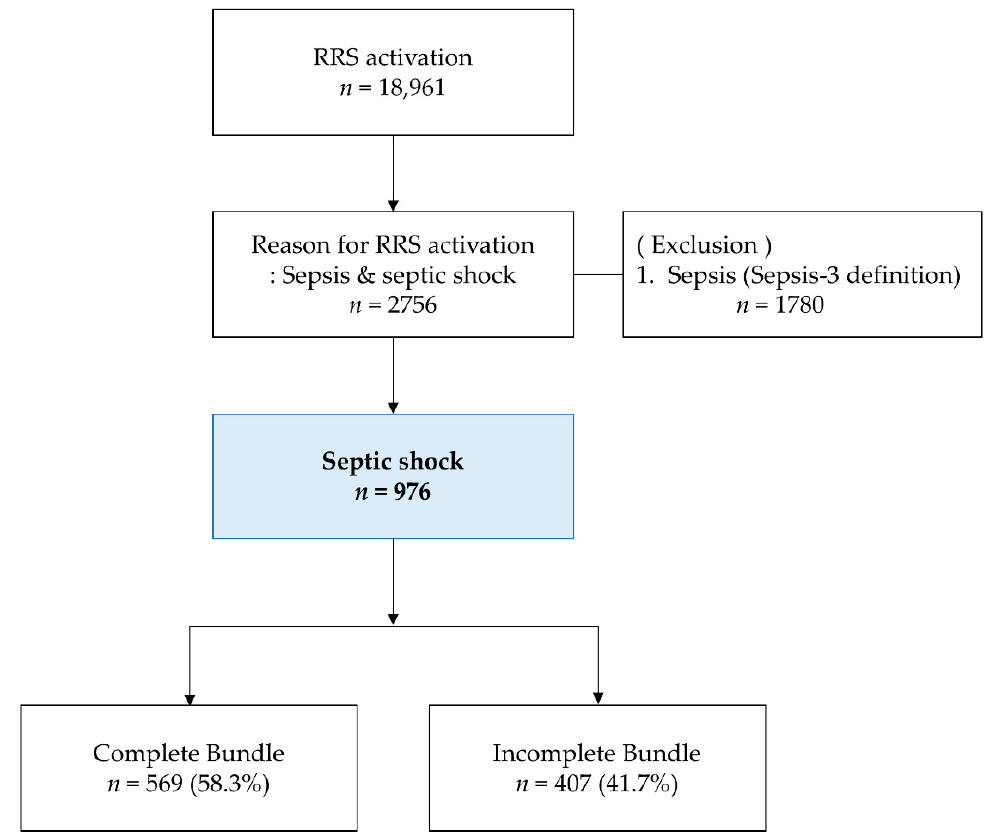
Figure 1. Flow diagram of the process of selection of study patients. Table 1. The 3 h and 6 h elements and compliance of sepsis bundle for patients with septic shock.